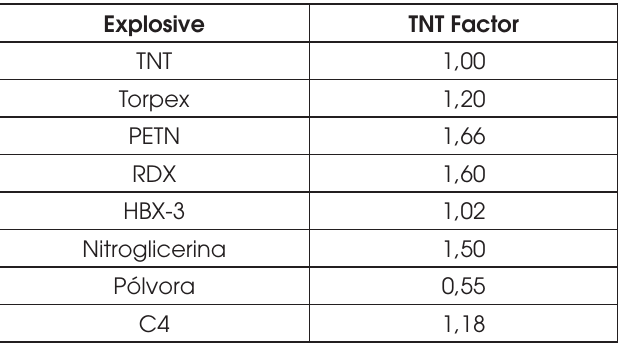
Explosives and their TNT equivalency [9] Explosive TNT